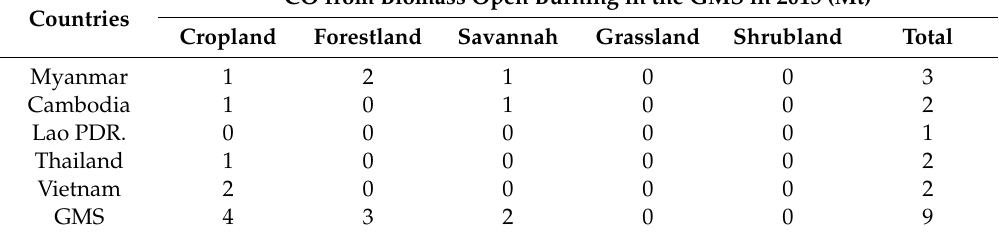
Table A4. The actual amount of CO from biomass open burning classified by vegetation types in the GMS in 2015. Countries